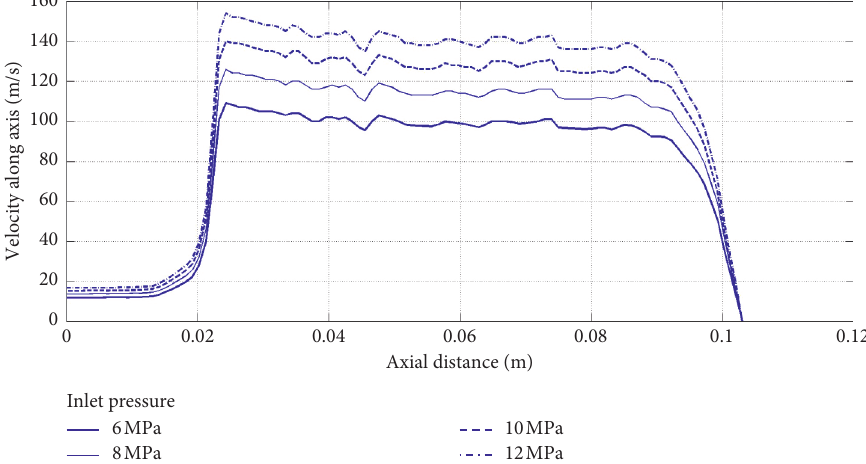
Figure 9: Axial velocity curves under different inlet